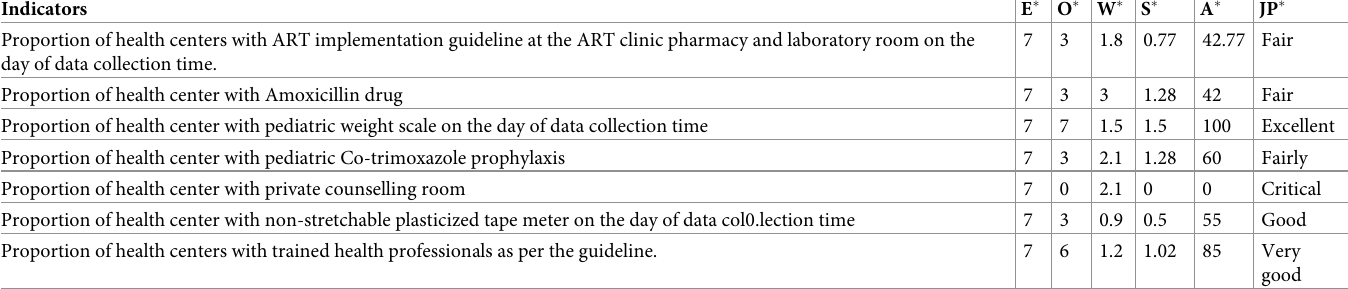
Table 1. Summary of ART resource availability indicators in the last three months in GCAHCs, April 2020.